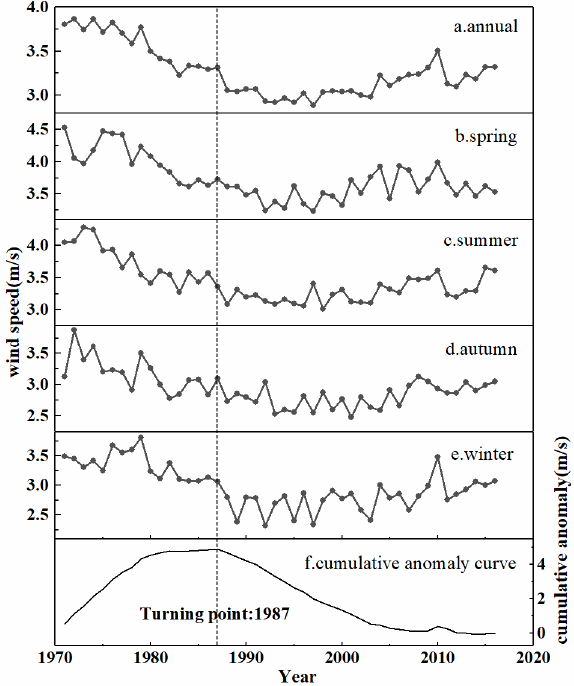
Figure 2. Change process of ( a ) annual, ( b ) spring, ( c ) summer, ( d ) autumn, ( e ) winter wind speed and ( f ) cumulative anomaly curve of annual wind speed in the BJD. The black dots and line indicate the annual and seasonal wind speed during 1971–2016; the black solid line indicates the cumulative anomaly curve of annual wind speed during 1971 to 2016; the black dashed line means the turning point.